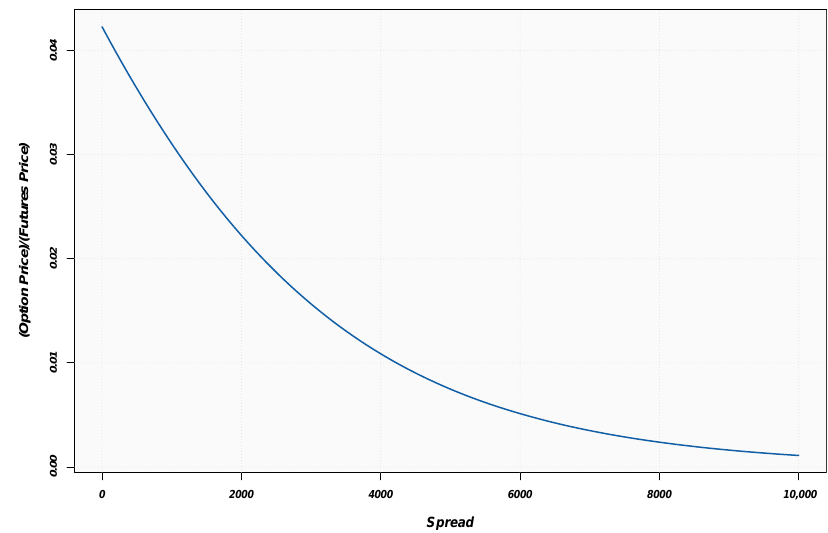
Figure 5. Bitcoin futures spread option